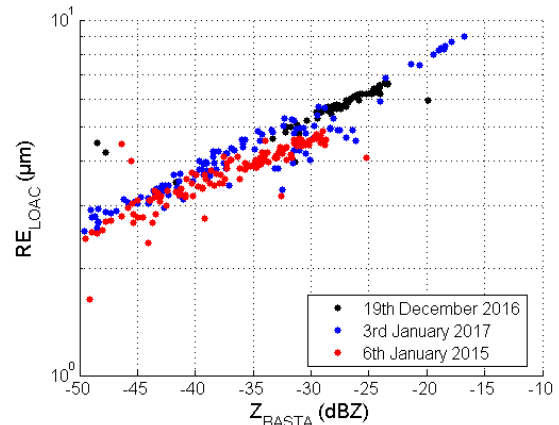
Figure 5. Relationship between effective radius (Re) measured with the LOAC sensor and radar reflectivity measured with BASTA for the three case studies (black markers for 19 December 2016, blue markers for 3 January 2017 and red markers for 6 January 2015).